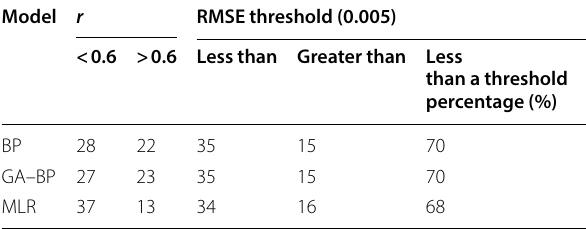
Table 3 Comparison of running results of three models Model